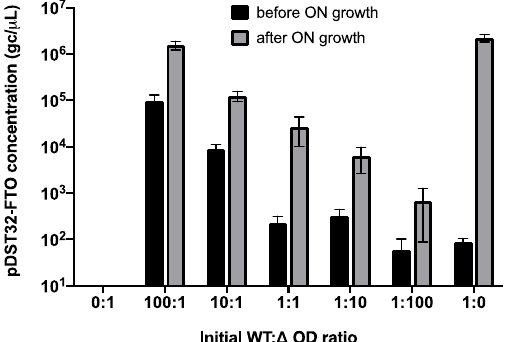
Figure 5. Evolution of pDST32-FTO phagemid copy numbers in mixed cultures of competing TG1/pDST32-FTO (WT) and TG1/pDST32- ∆ ssgIII ( ∆ ) cells. Medium was inoculated with different amounts of cells in the corresponding ratios (1 amount equalled OD = 0.001) and grown overnight at 37 °C. pDST32-FTO phagemid concentrations (gc/µL) were determined by qPCR using FTO -